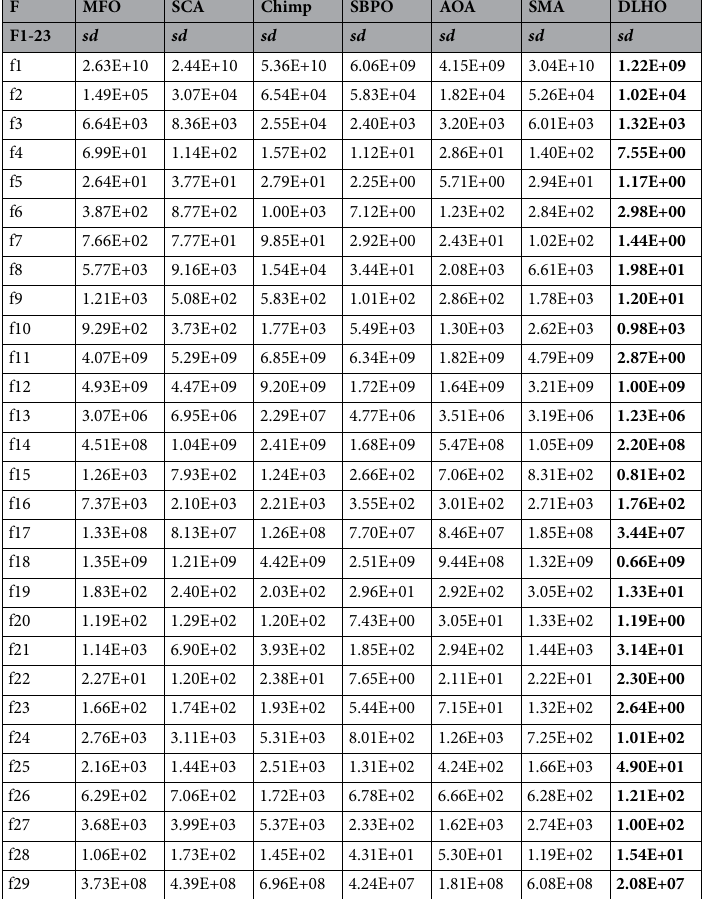
Table 6. Standard deviation ( sd ) outcomes of optimizers on 29-CEC-2017